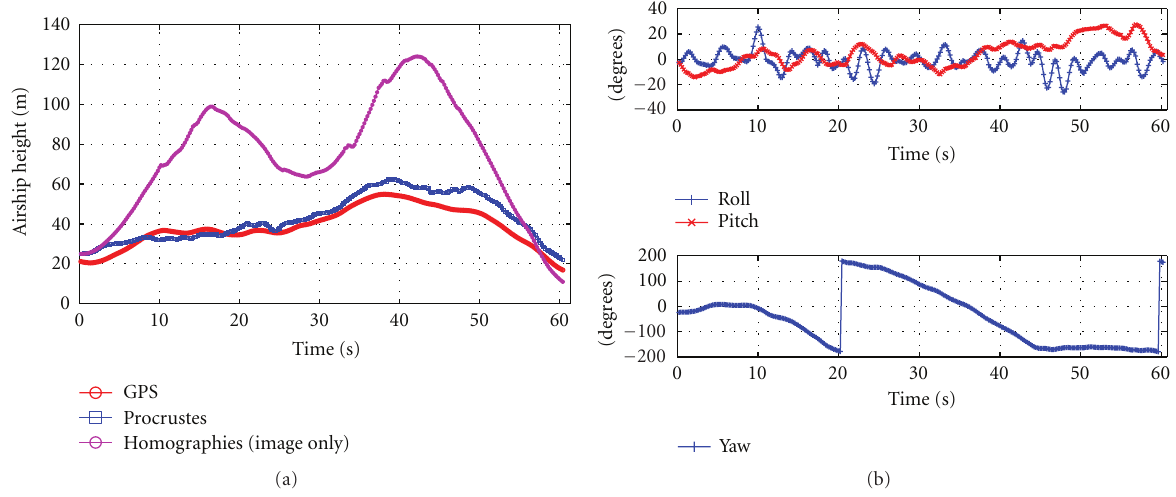
Figure 8: The airship height from GPS and visual odometry (a) and the attitude angles measured by the AHRS (b).